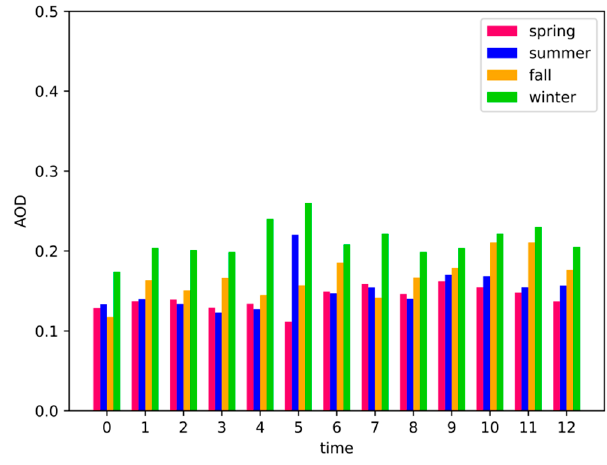
Figure 7. Seasonal average AOD in Sansha.